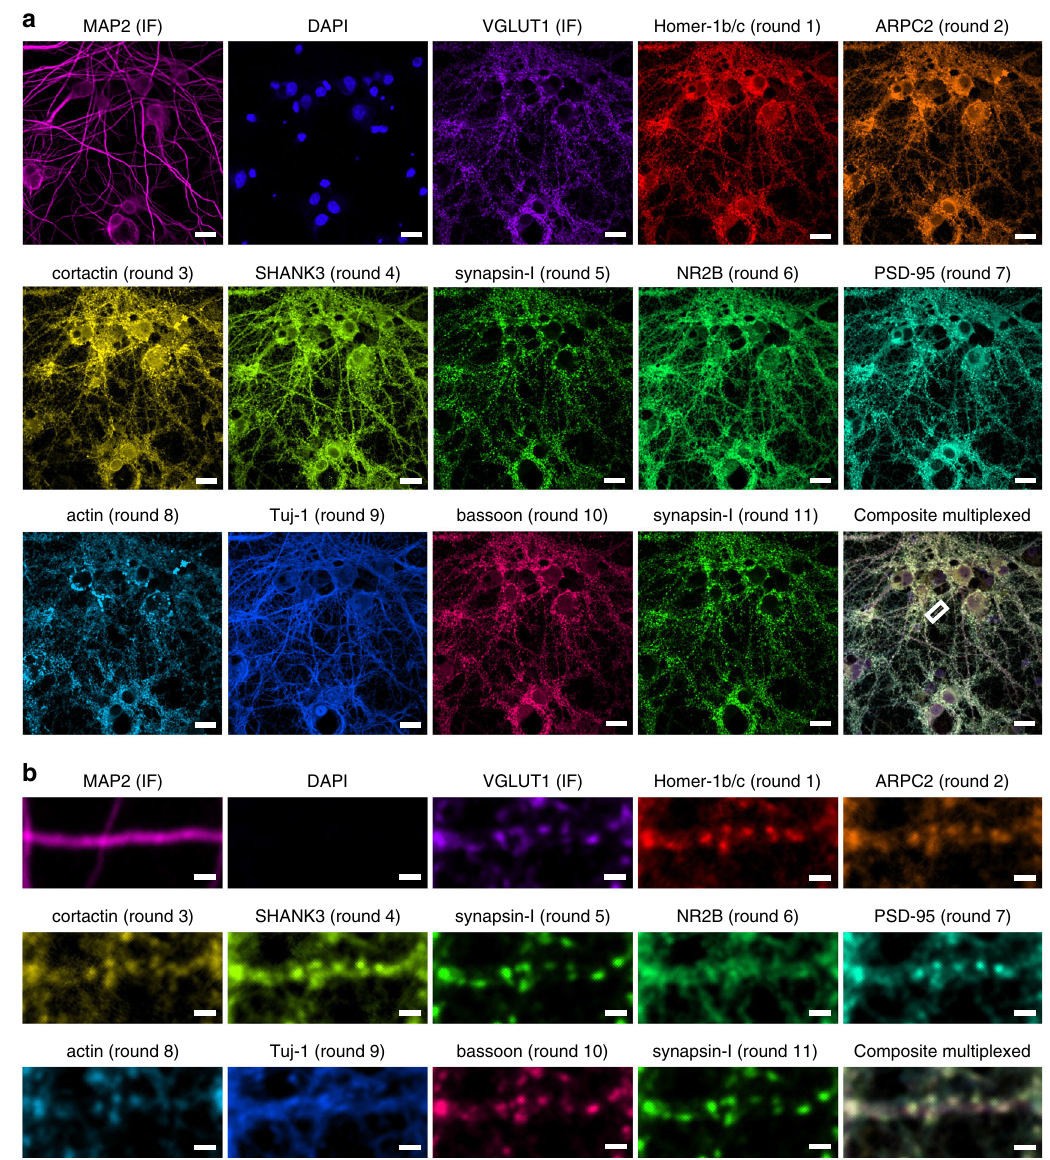
Fig. 3 Confocal LNA-PRISM images of rat hippocampal neuronal synapses. a 13-channel images of 21 days in vitro (DIV) rat hippocampal neuronal culture from a single fi eld of view. Individual channels for each marker are shown followed by a composite image in the bottom-right corner. MAP2 and VGLUT1 were visualized using fl uorescently labeled secondary antibodies, nuclei were visualized using DAPI, and all other targets were visualized using ssLNA imaging probes. Synapsin-I was imaged twice, once in the middle and once at the end of the experiment. b Zoom-in view of a single dendrite indicated by the white box in a . Scale bars: a 20 μ m; b 2 μ